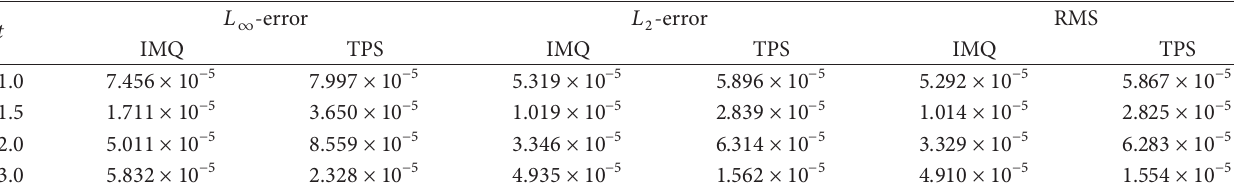
Table 3: Numerical errors using IMQ ( 𝑐 = 0.08 ) and TPS ( 𝑚 = 2 ) represented at different times, where 𝑑𝑥 = 0.01 , 𝑑𝑡 = 0.001 , and 𝜃 = 1/2 . 𝑡